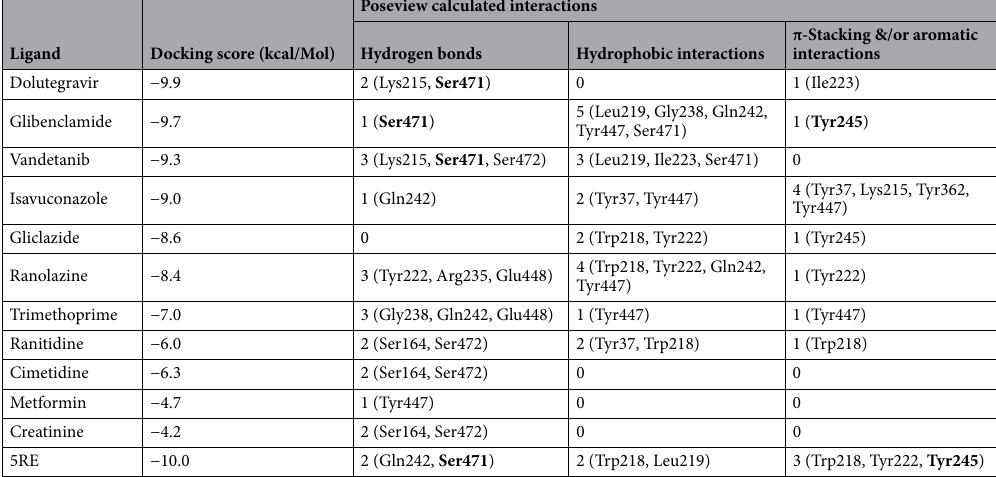
Table 8. Docking scores and number of interactions predicted for 11 drugs and 5RE inhibitor docked to the active site of SLC22A2 haplotype 3. Interactions calculated using Poseview. Number in front of brackets is the total number of interactions observed. Three letter aa code: Lys lysine, Ile isoleucine, Ser serine, Leu leucine, Gly glycine, Gln glutamine, Tyr tyrosine, Arg arginine, Glu glutamic acid. The residues highlighted in bold shows similar interacting residues shared between the top binders: i.e. 5RE, Dolutegravir, Glibenclamide, Vandetanib and Isavuconazole.